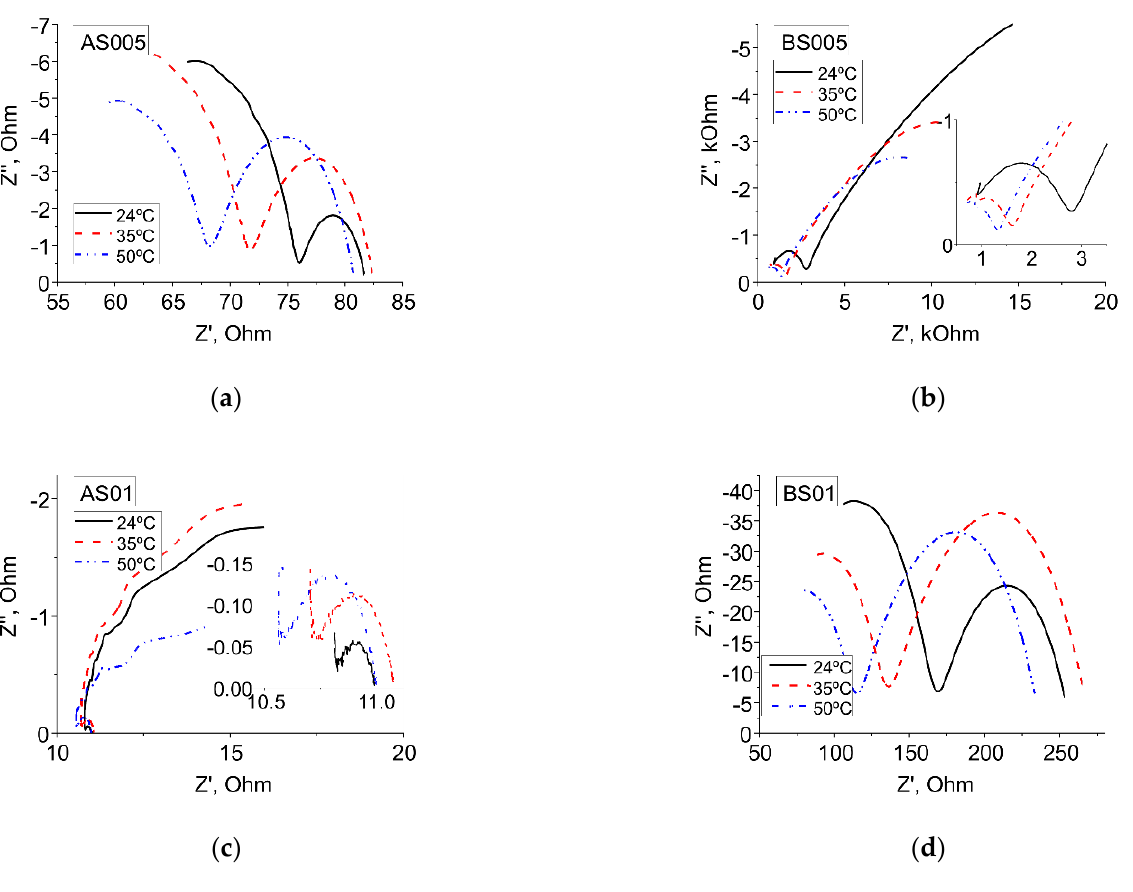
Figure 5. Nyquist plots for reinforced mortars at different sample temperatures: ( a ) AS005; ( b ) BS005; ( c ) AS01; and ( d ) BS01.